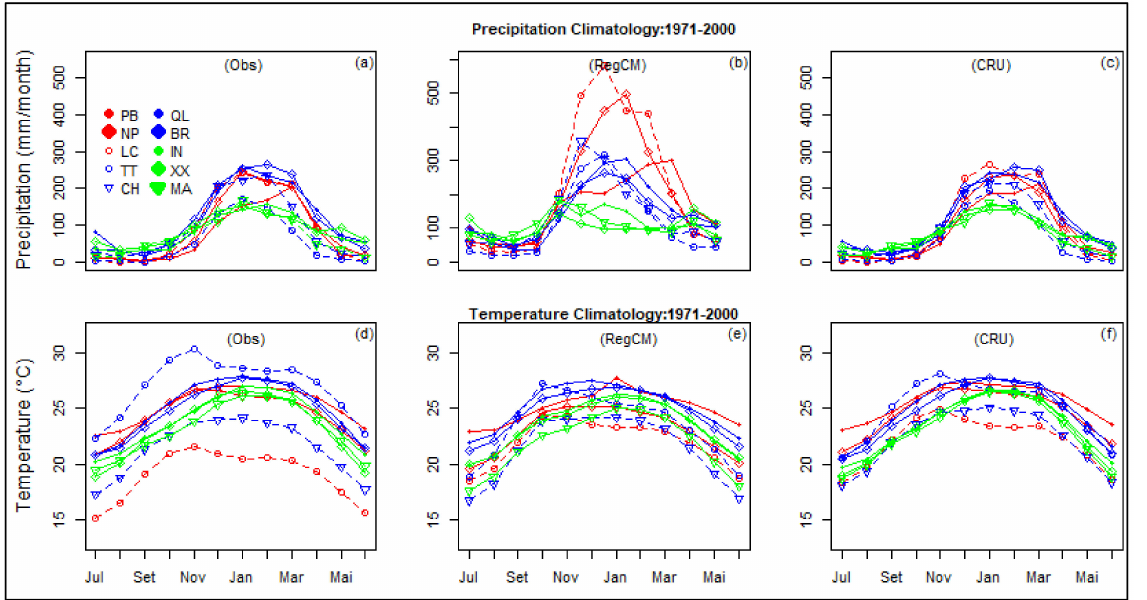
Figure 3. Climatology of the annual cycle of observed and simulated precipitation and air temperature in each representative WS of the study domain. Red, blue, and green are the north, central, and southern WS, respectively. The open (filled) circle indicate the coastal (continental) WS.